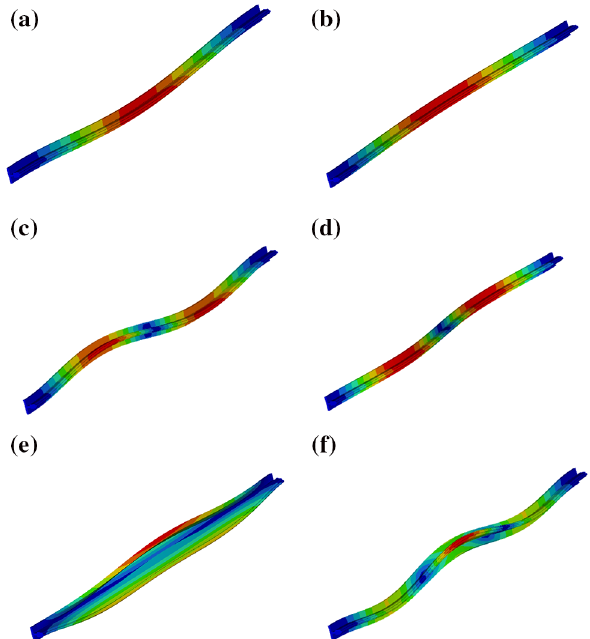
Fig. 3 The first six order vibration modes of the catenary. a First- order modal shapes of catenary. b Second-order modal shapes of catenary. c Third-order modal shapes of catenary. d Forth-order modal shapes of catenary. e Fifth-order modal shapes of catenary. f Sixth-order modal shapes of catenary